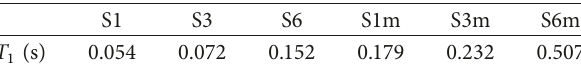
1 of the tested